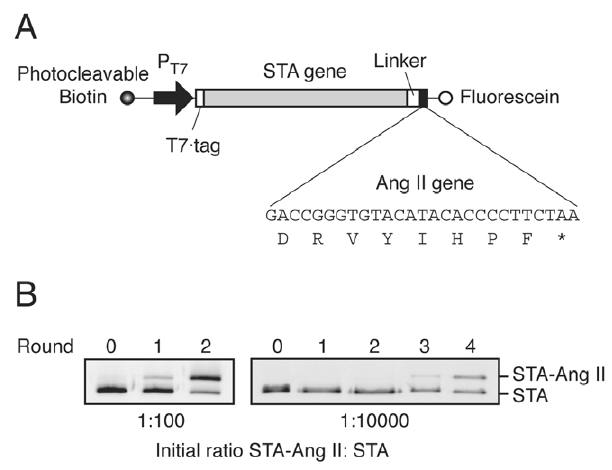
Figure 3. Construction and enrichment of the streptavidin- fused angiotensin II (STA-Ang II) gene in multiple rounds of DNA-display selection on hAT1R/CHO-K1 cells. ( A ) A schematic representation of the DNA template for in vitro transcription/translation. DNA was labeled during PCR with photocleavable biotin [22] at the upstream ends and with fluorescein at the downstream ends, using labeled primers. The translated open reading frame consists of sequences for a T7 ? tag, streptavidin (STA), a peptide linker, and Ang II gene. The 5 9 -UTR fragment contains T7 promoter. ( B ) Reaction mixtures containing 1:100 or 1:10,000 molar ratio of STA-Ang II: STA genes were emulsified. The DNA after each round of selection was PCR-amplified with a fluorescein-labeled primer and analyzed by 15% PAGE with an imaging analyzer.